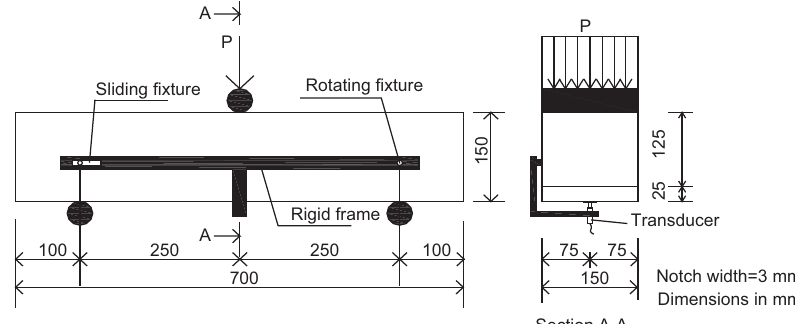
Figure 2 Flexural test setup.